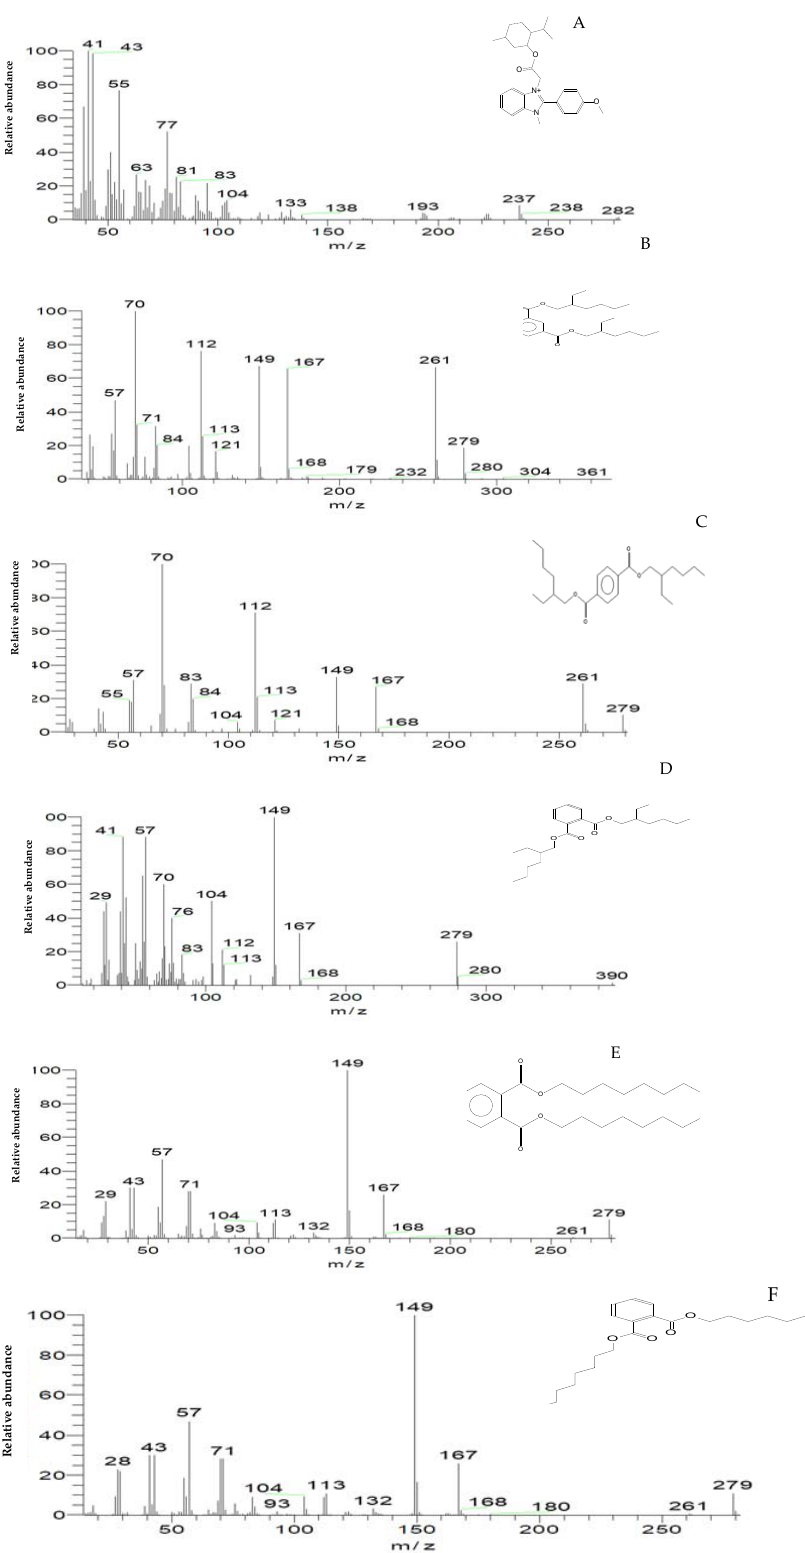
Figure 12. The mass spectrum of intermediates of the MG degradation identified by GC–MS analysis. ( A ) Di(tert-butyl)(2-phenylethoxy)silane (retention time 4.05); ( B ) 1,3-Benzenedicarboxylic acid, bis(2-ethylhexyl) ester (retention time 36.52); ( C ) 1,4-Benzenedicarboxylic acid, bis(2-ethylhexyl) ester (retention time 36.52); ( D ) 1,2-Benzenedicarboxylic acid (retention time 36.52); ( E ) Di-n-octyl phthalate (retention time 36); ( F ) 1,2 ‐ benzenedicarboxylic acid, dioctyl ester (retention time 36.52).